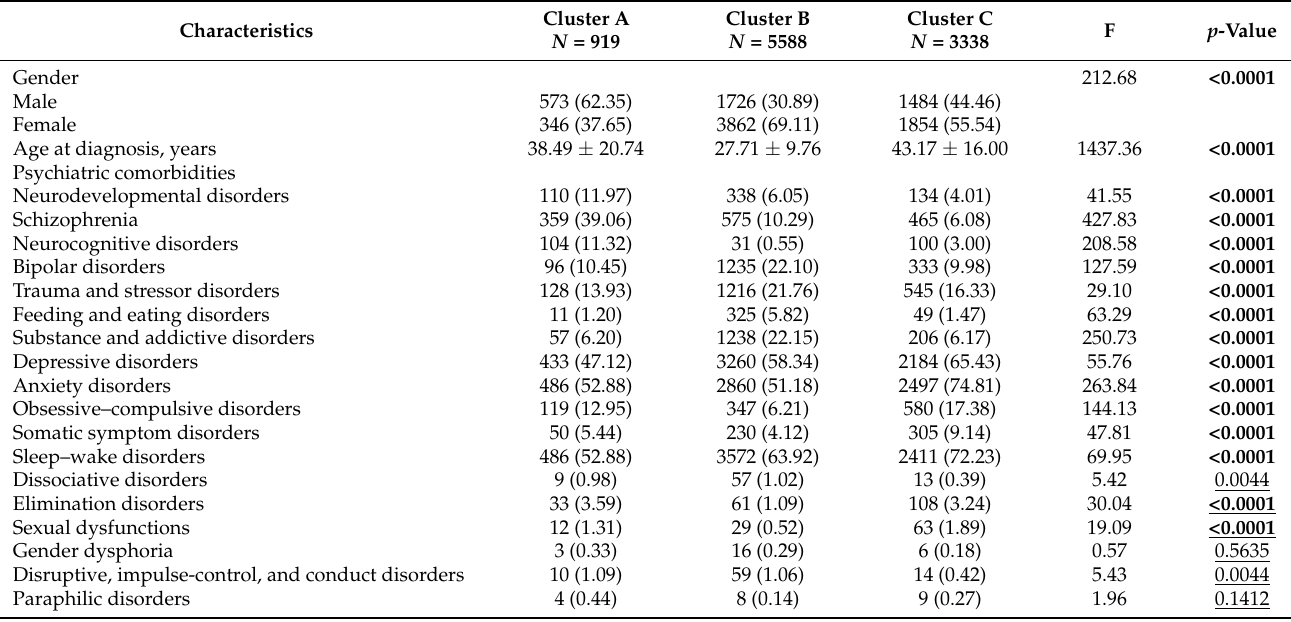
Table 1. Characteristics of individuals in cluster A, cluster B, and cluster C personality disorder groups.